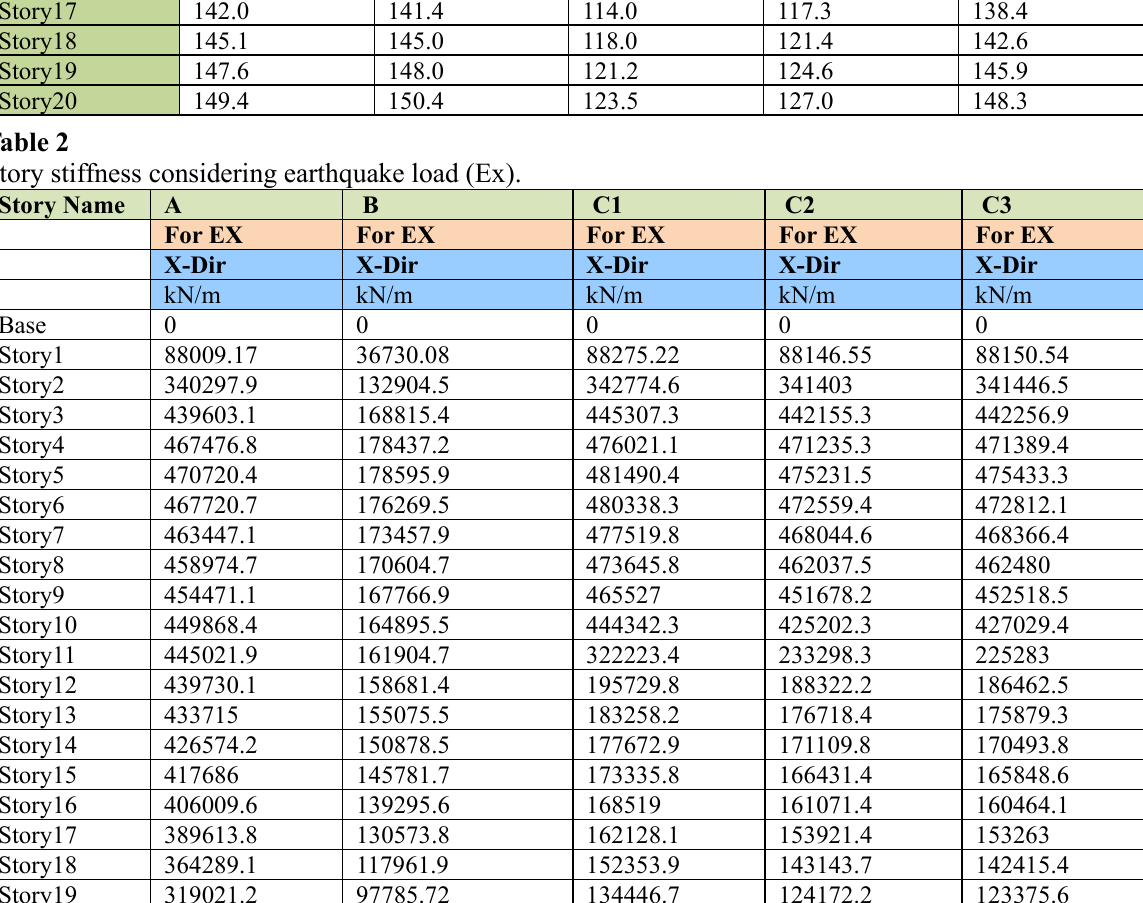
Story stiffness considering earthquake load